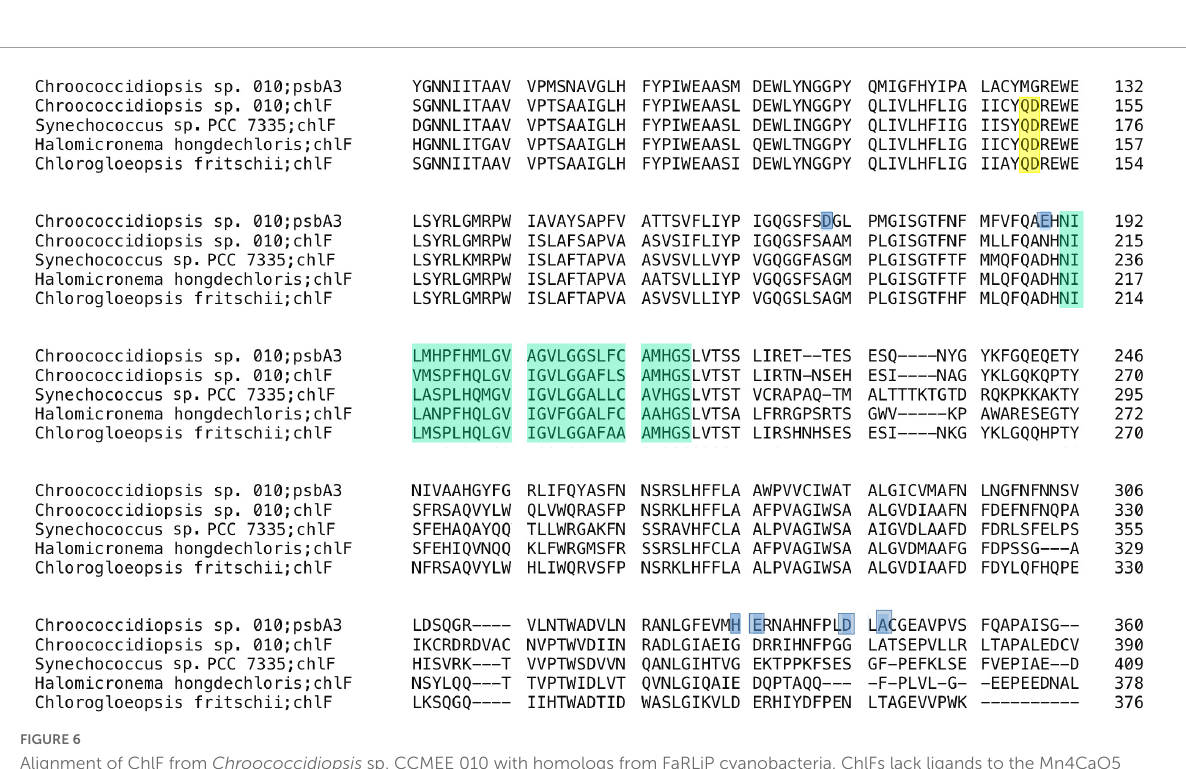
FIGURE6 Alignment of ChlF from Chroococcidiopsis sp. CCMEE 010 with homologs from FaRLiP cyanobacteria. ChlFs lack ligands to the Mn4CaO5 oxygen-evolving center shaded blue in the PsbA3 sequence of CCMEE 010 and show the conserved QD residues shaded yellow. Photosynthetic reaction center proteins signature (PROSITE entry PS00244) is shaded green. UniProtKB: P0DOC9 (CHLF_CHLFP); B4WP19 (CHLF_SYNS7); A0A1Z3HIN9